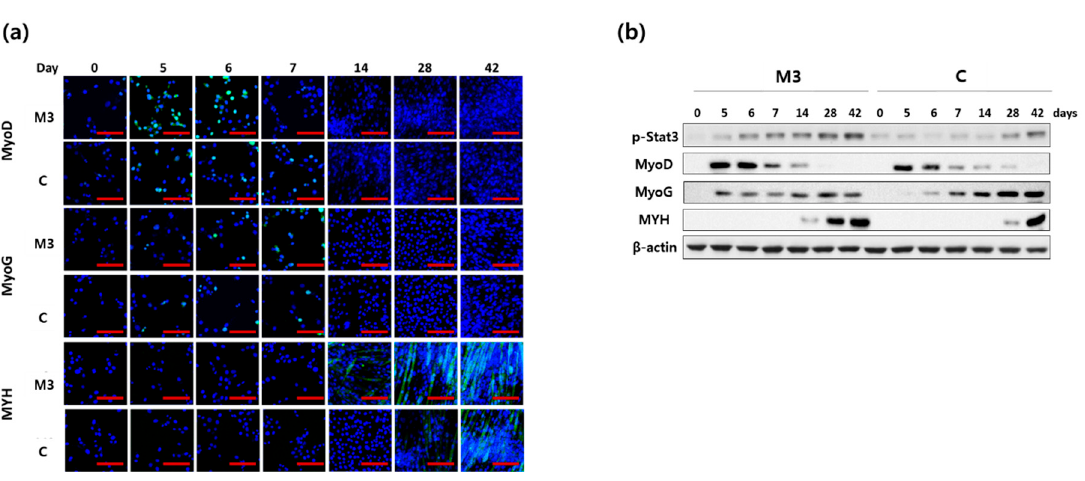
Figure 3. Effect of a combination of IL-6 and C2C12 CM on MyoD, MyoG and MYH protein expression during myogenic differentiation. ( a ) The expression of MyoD, MyoG and MYH were checked by immunofluorescence staining (scale bar, 200 μ m) ( b ) The expression of MyoD, MyoG, MYH and p-STAT3 was analyzed by western blotting.